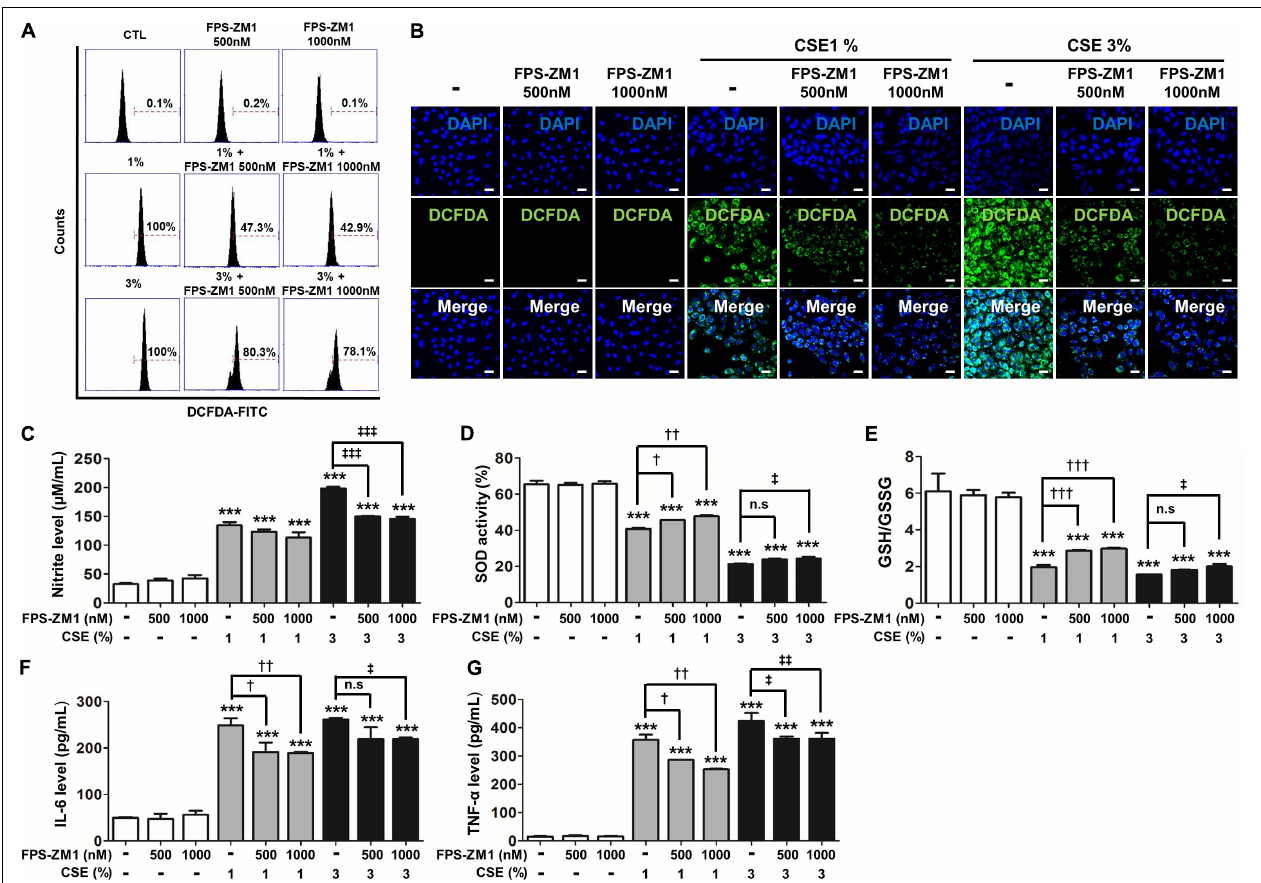
FIGURE 4 | The effect of FPS-ZM1 treatment on CSE-induced intracellular RONS and inflammation in human alveolar epithelial cells. The A549 cells were incubated in the presence of FPS-ZM1 (500–1000 nM) for 24 h, followed by incubation in the presence (1–3%) or absence of CSE for 8 h. The antioxidant effects of FPS-ZM1 in CSE-exposed cells were evaluated by degree of scale of loaded DCF-DA. (A) The fixed quantity of oxidated DCF-DA probe was evaluated by fluorescence-activated cell sorting (FACS). The x -axis indicate the intensity of intracellular DCF-DA fluorescence, and the y -axis represent the mean number of live cells in flow cytometry histograms. (B) The cells exposed to CSE and/or FPS-ZM1 were imaged using confocal laser scanning microscopy. Nuclei stained with DAPI (blue). (C) The anti-nitration (NO generation) effect of FPS-ZM1 in CSE-exposed cells was indicated by modified Griess reaction in culture supernatants. (D) Total SOD activity was measured in cell lysate exposed to CSE and/or FPS-ZM1. (E) The ratio of glutathione (GSH)/oxidized glutathione (GSSG) was detected at different reaction time using a colorimetric assay at OD 412nm . The level of (F) IL-6 and (G) TNF- α were determined by ELISA in culture supernatants. All figures are representative of three independent experiments, performed in triplicate. Data are expressed as means ± SE. CTL, no treatment; n.s, not significant. ∗∗∗ p < 0.001 vs. CTL; † p < 0.05, †† p < 0.01, and ††† p < 0.001 vs. 1% CSE treatment; ‡ p < 0.05, ‡‡ p < 0.01, and ‡‡‡ p < 0.001 vs. 3% CSE